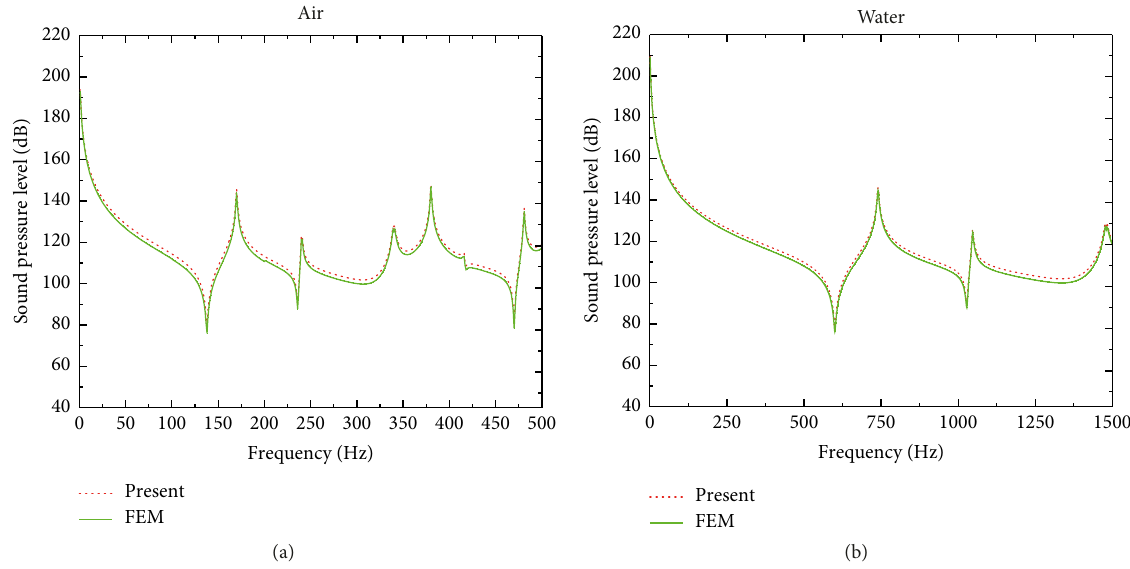
Figure 11: Acoustic pressure response of the triangular prism acoustic cavity with impedance walls under the unit point sound source excitation.